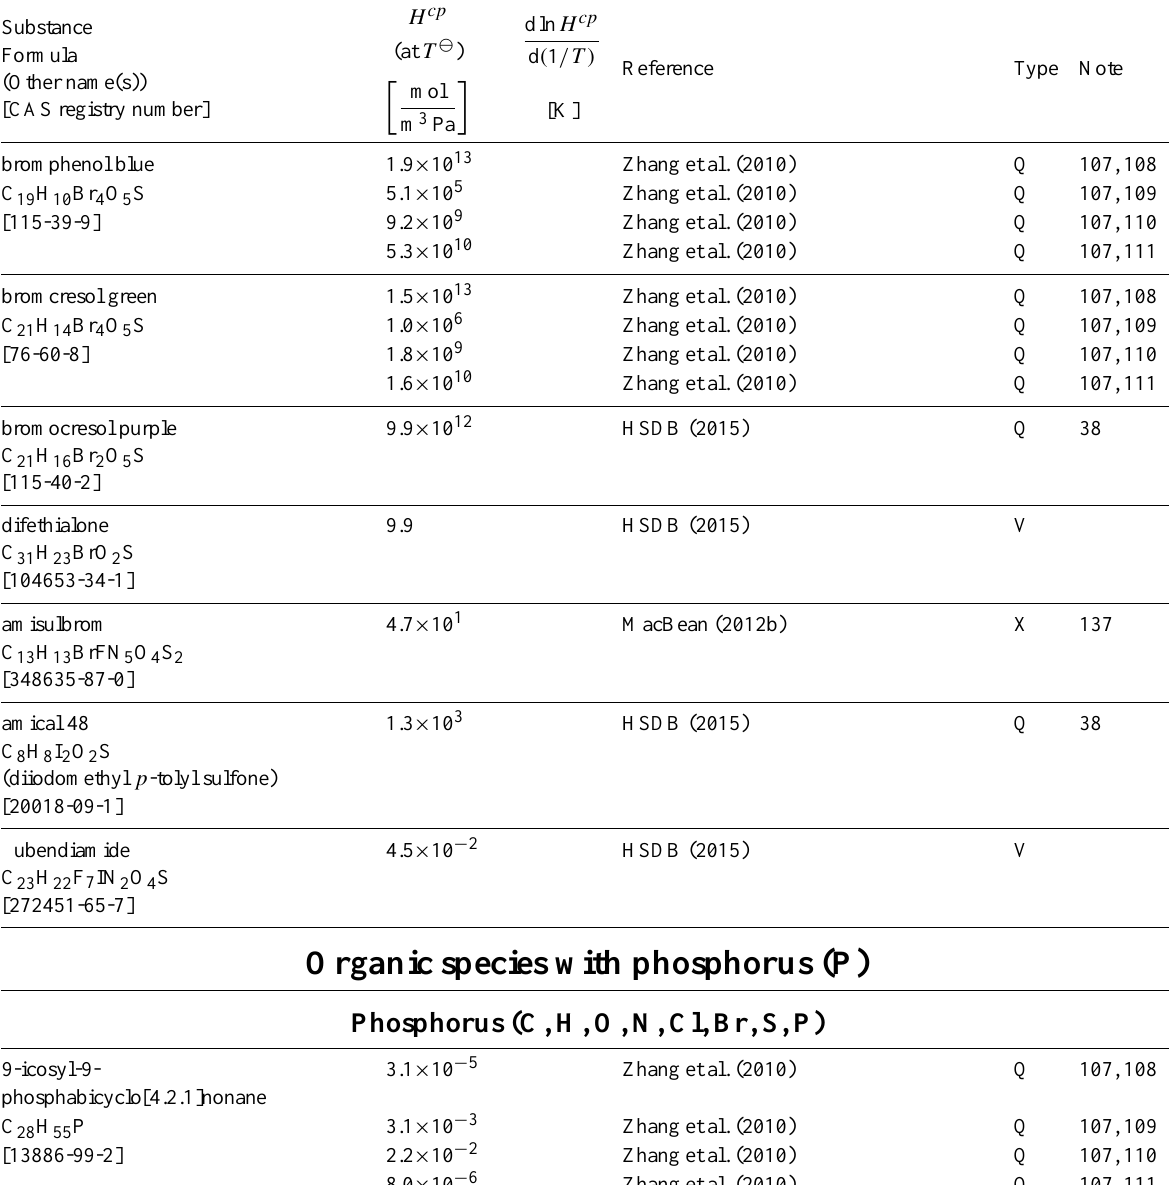
Table 6: Henry’s law constants for water as solvent